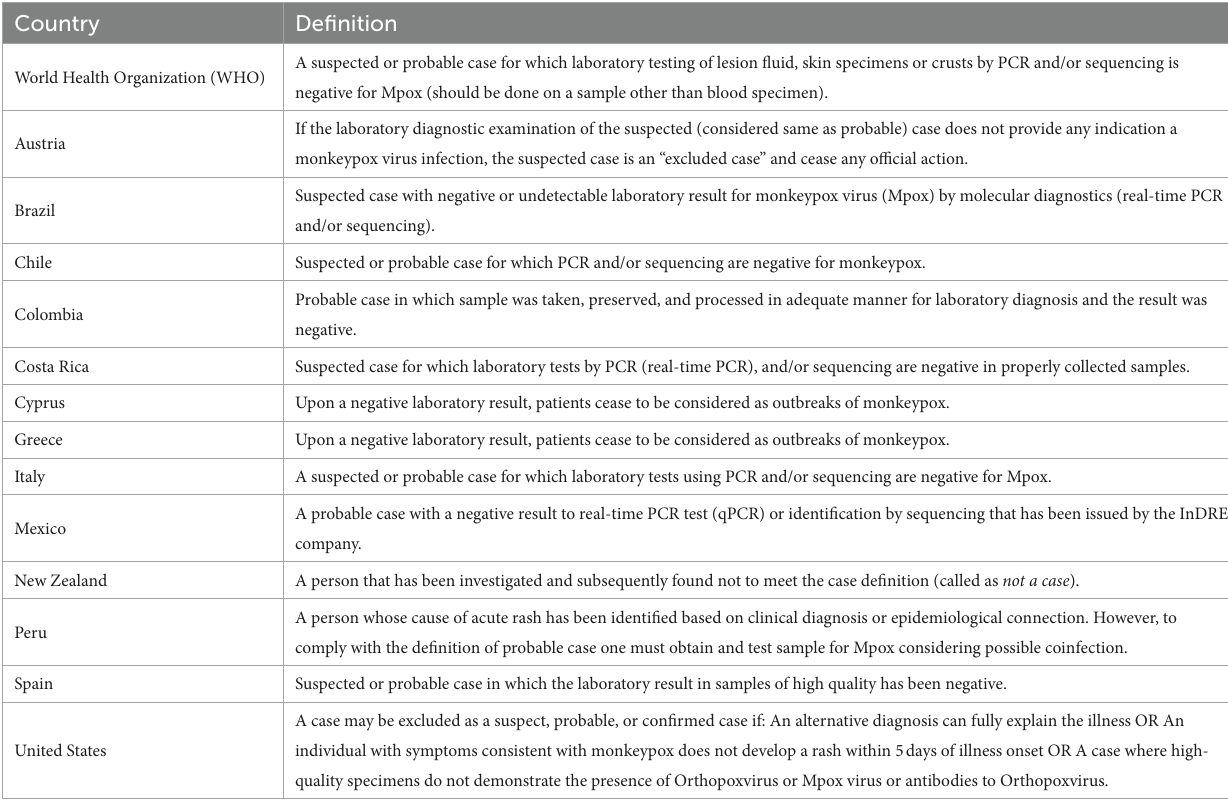
TABLE 5 Definition of discarded cases according to national guidelines in the investigated countries.